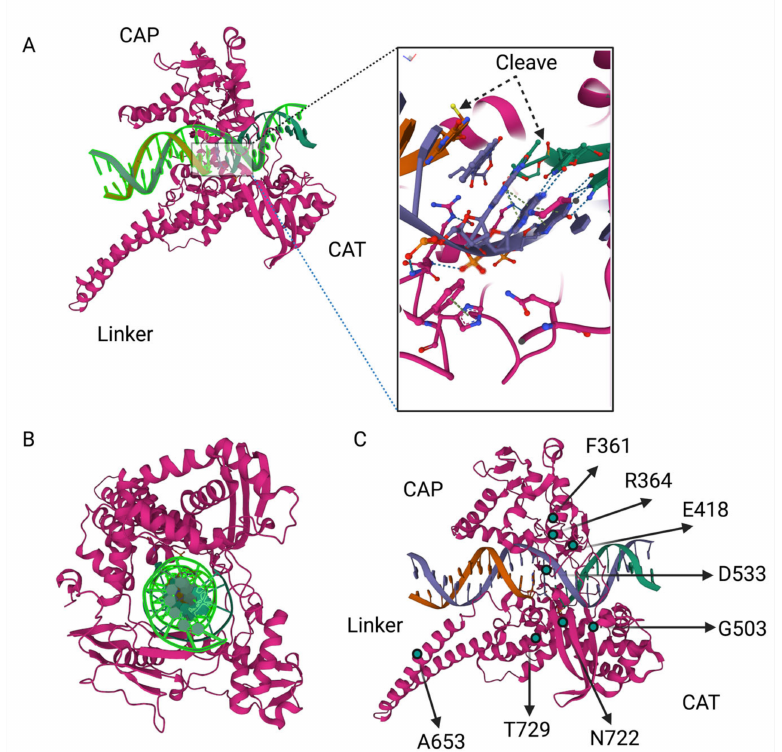
Figure 3. Crystal structure model for topoisomerase I. ( A ) Showing two domains, DNA placement and cleavage, ( B ) sections showing Top1 wrapped around DNA, ( C ) Irinotecan-resistance mutations in Top1 (not exact scale and is for representation based on data from public depository, http://doi. org/10.2210/pdb1k4t/pdb, accessed on 12 February